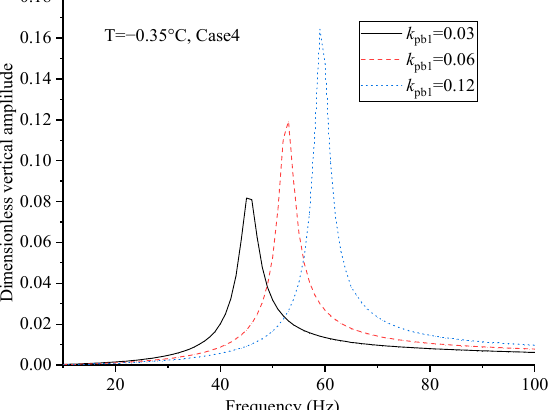
Figure 10. Influence of pile bottom-support stiffness ( k pb1 ) on the amplitude–frequency curves of the single-pile foundation.